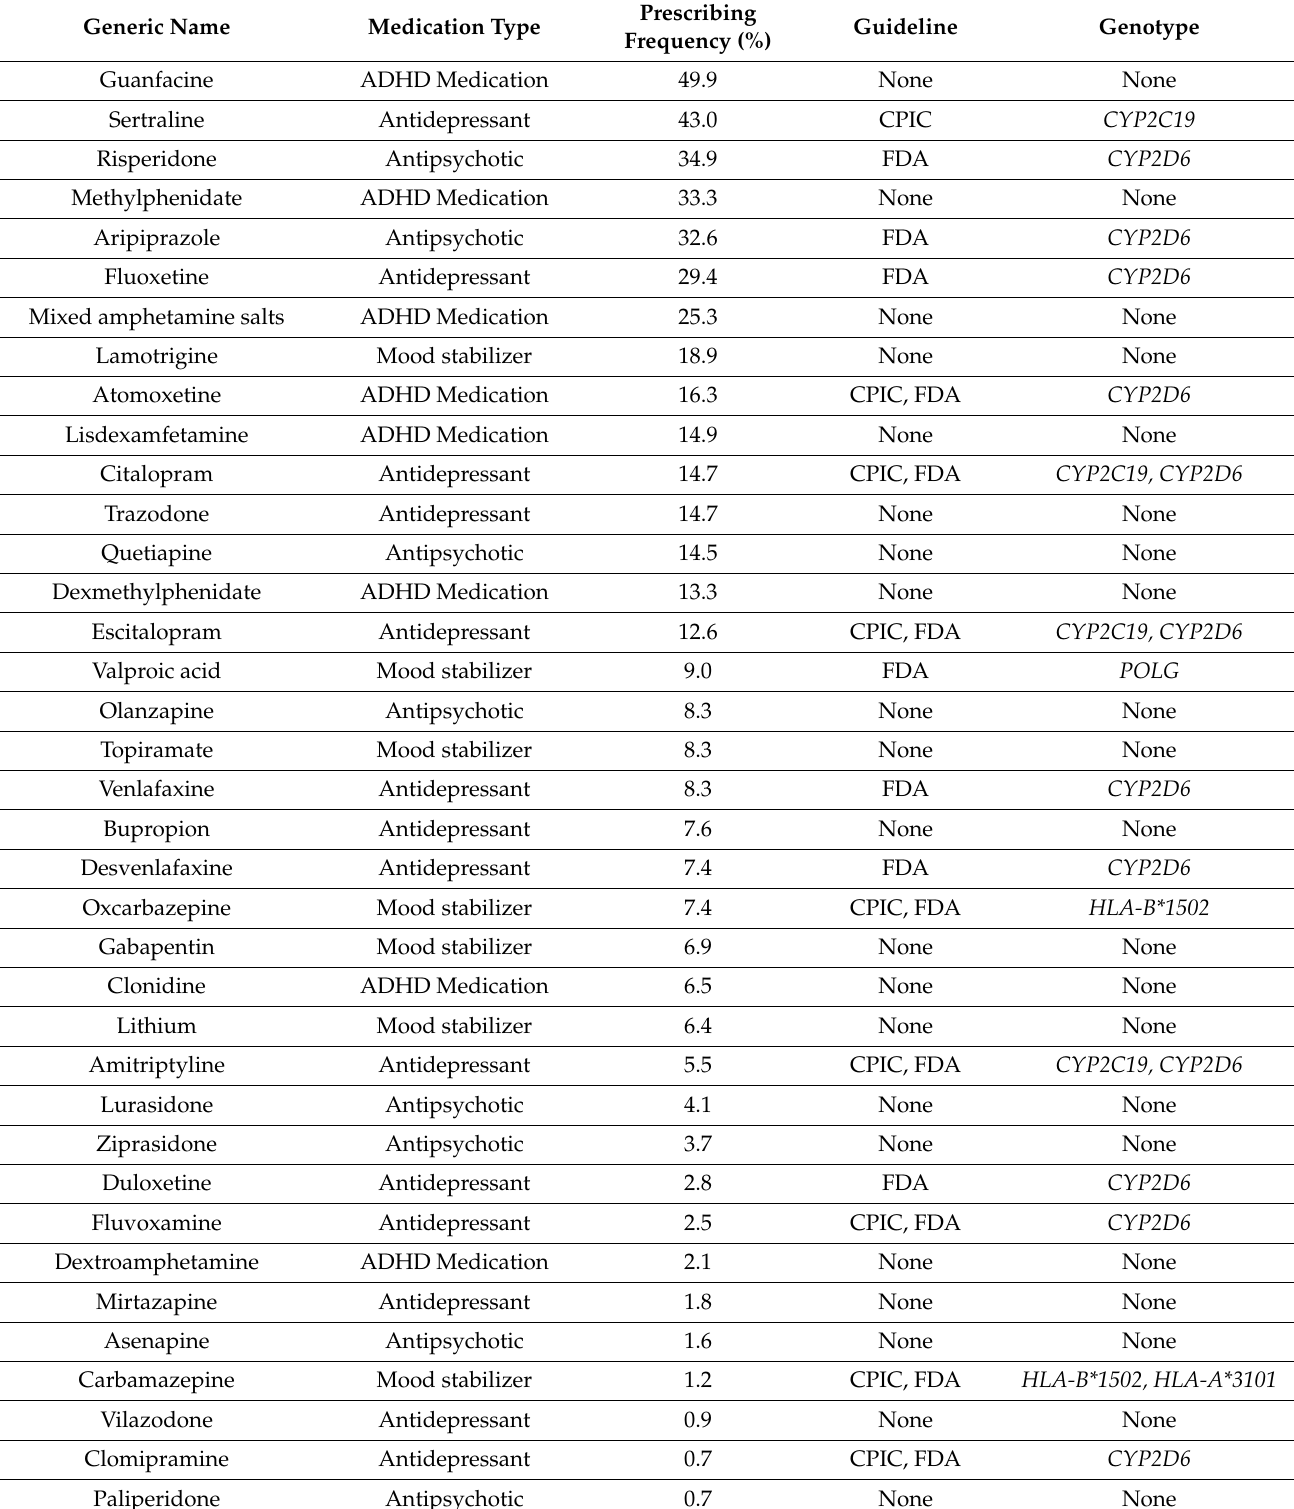
Table 2. Frequency distribution of psychotropic medications (N = 47; as percentage; in descending order of prescribing frequency) being prescribed to the study cohort (N = 435) at any time during the study period, and their respective pharmacogenetics